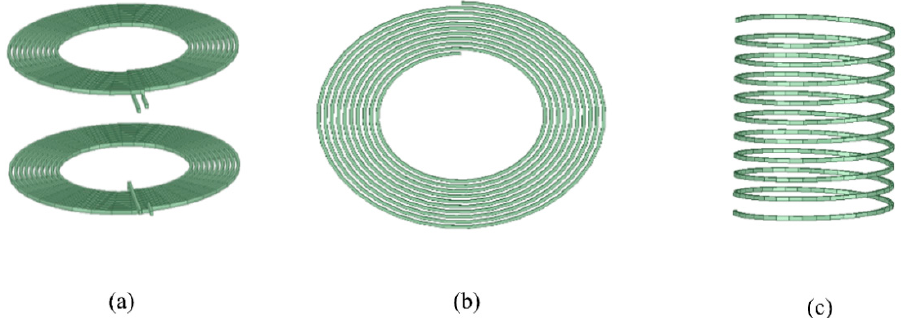
Figure 5. Coil model diagram. ( a ) Two coil model, ( b ) Single coil model, ( c ) Cylindrical spiral coil model.